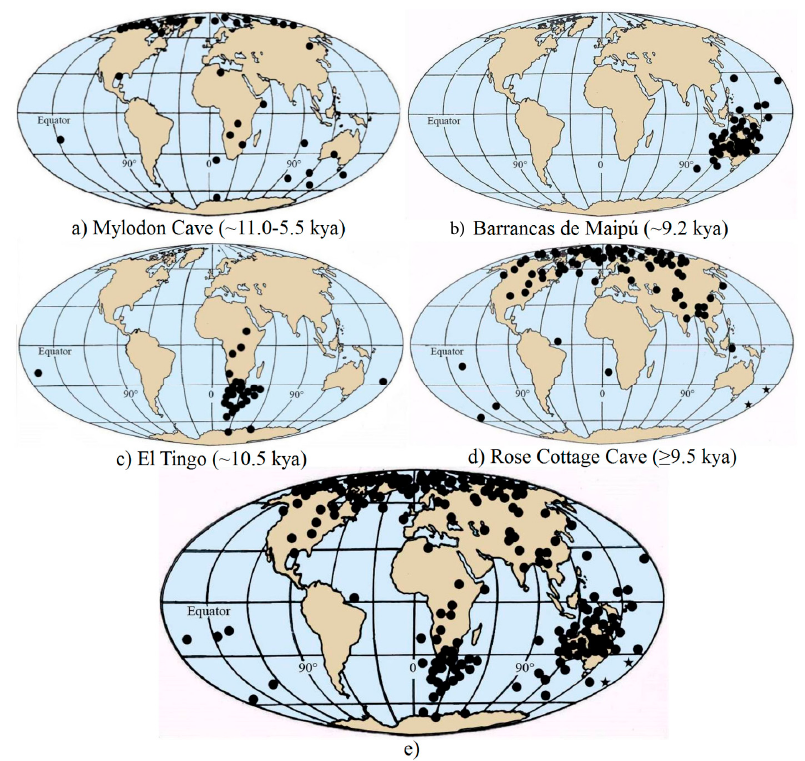
Figure 18. World map and location of the virtual geomagnetic poles calculated from samples with anomalous directions recorded during the Pleistocene-Holocene transition and early Holocene in some sites from: ( a ) Chile, ( b ) Argentina, ( c ) Ecuador, ( d ) South Africa, ( f ) The totality of Virtual Geomagnetic Poles from the locales illustrated in ( a – d ). Modified after [129,136,137,149].